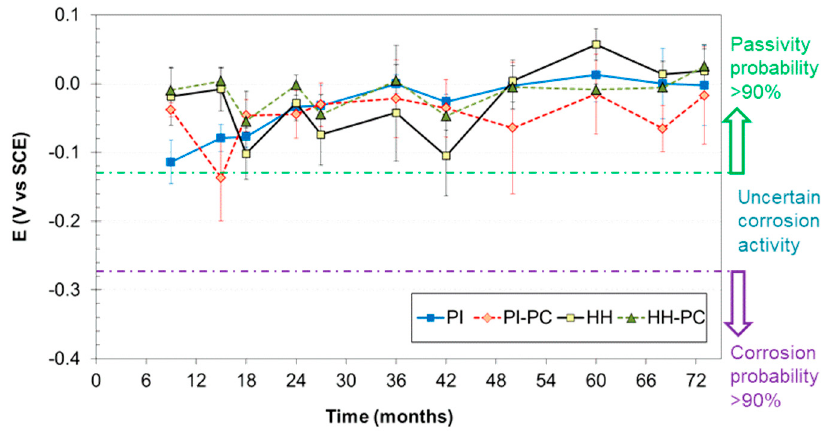
Figure 4. Corrosion potential (E corr ) values obtained for S32304 steel tested under di ff erent conditions. SCE: saturated calomel electrode.